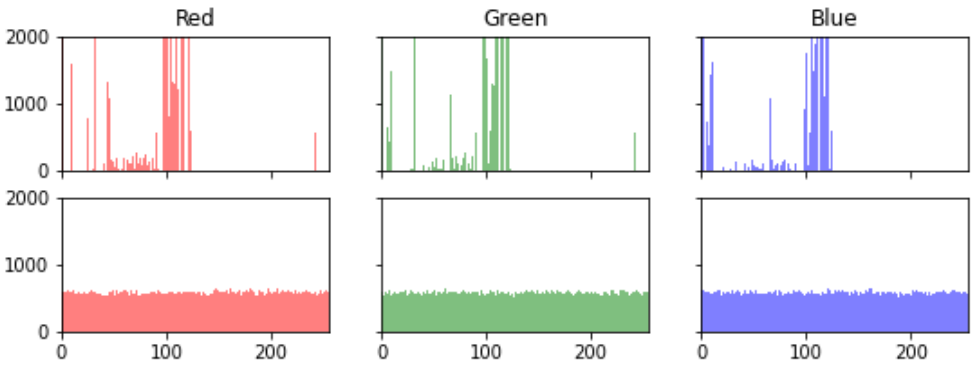
Figure 9. Histogram of the R, G, and B components of the pixels of the image version of Test File 3 ( top row ) and its cipher-image ( bottom row